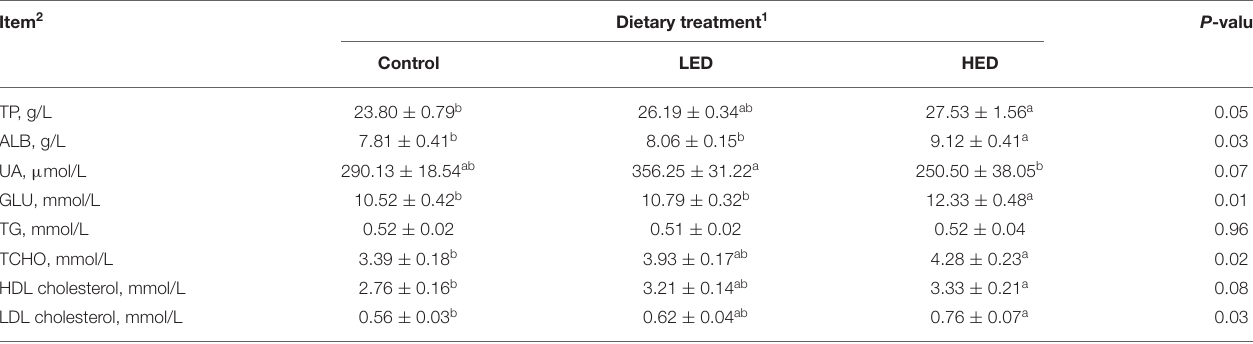
TABLE 5 | Effects of dietary energy levels on the plasma parameters in 10-day-old broilers. Item 2